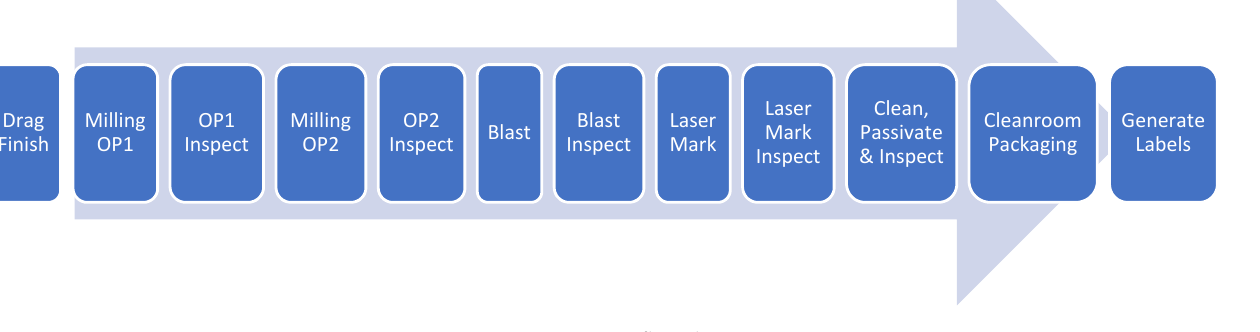
Figure 6. Process flowchart.